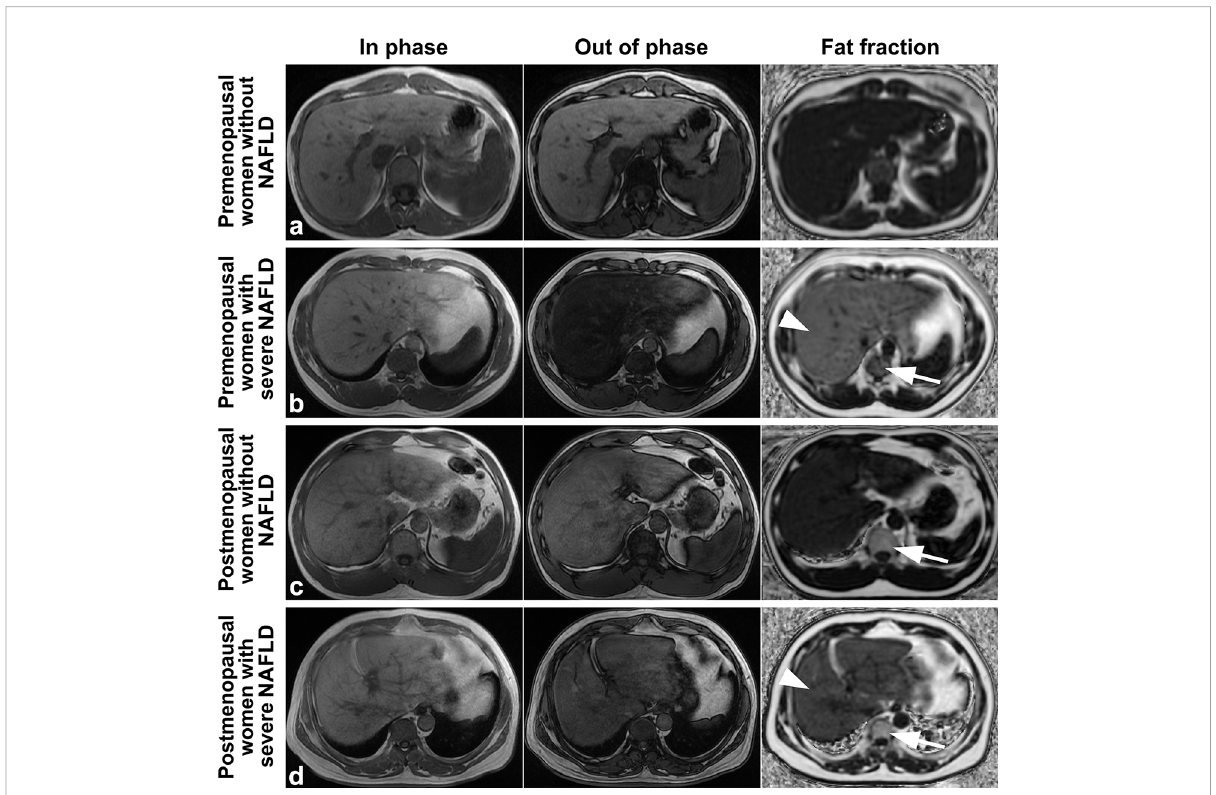
FIGURE 3 Images of premenopausal and postmenopausal women without NAFLD or with severe NAFLD (A) a 47 years old premenopausal woman without NAFLD; (B) a 45 years old premenopausal woman with severe NAFLD; (C) a 55 years old postmenopausal woman without NAFLD; and (D) a 57 years old postmenopausal woman with severe NAFLD). The fat deposition was visible by the decrease in the signal in the axial conventional T1- in phase and out-of-phase images of the mDIXON-Quant sequence and was measured in the fraction map of the IDEAL-IQ sequence. The